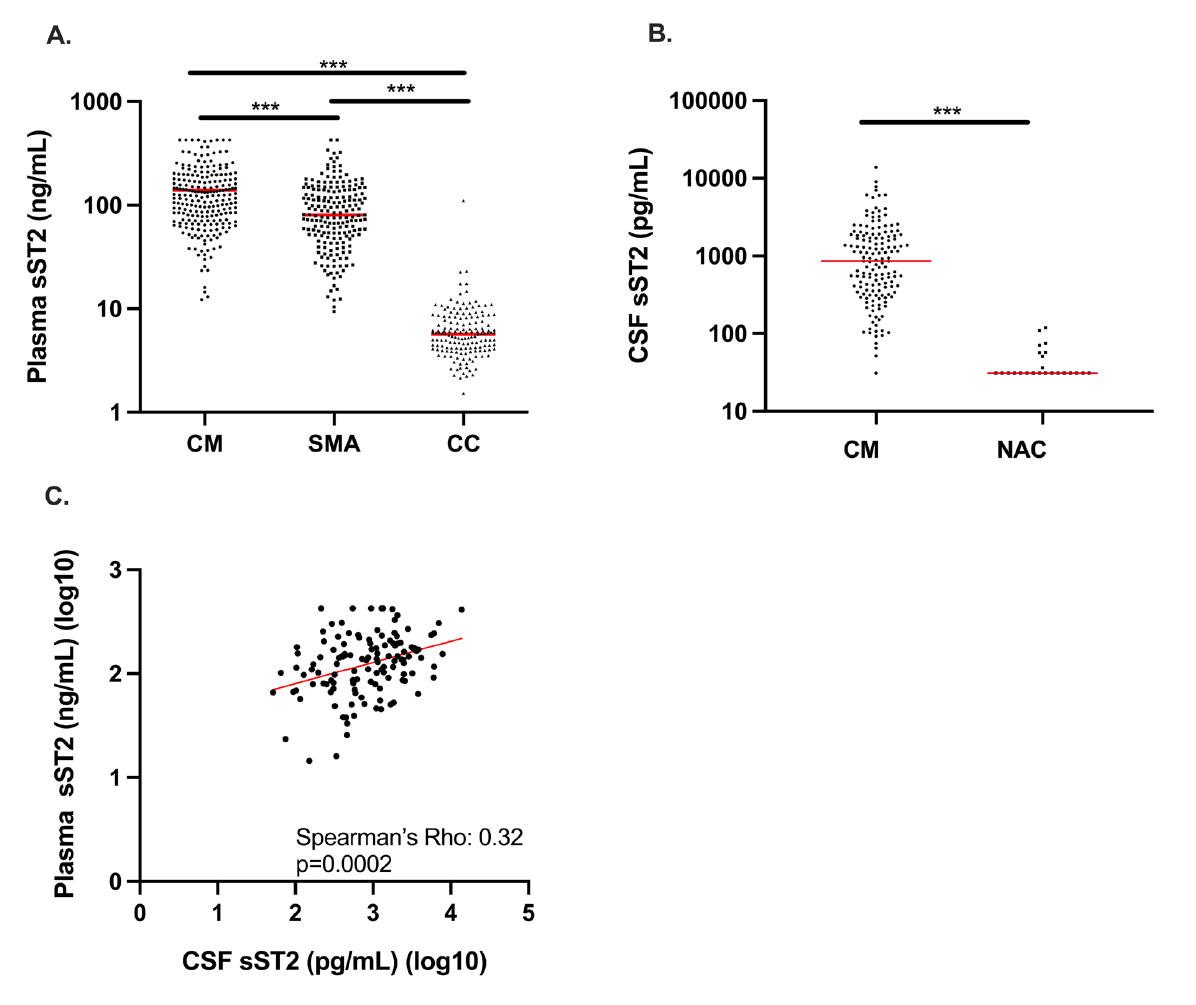
Figure 2. Plasma and CSF levels of sST2 in children with cerebral malaria (CM) or severe ma- larial anemia (SMA) and control children (CC).